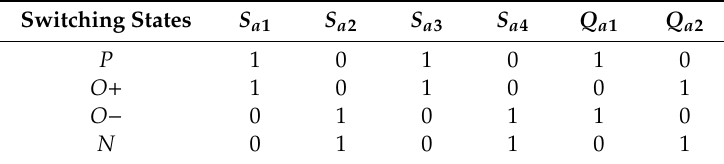
Table 1. In this table, the three-voltage states O , P , and N represent the zero, positive, and negative voltage levels, respectively. Table 1. Switching conditions of HANPC under healthy